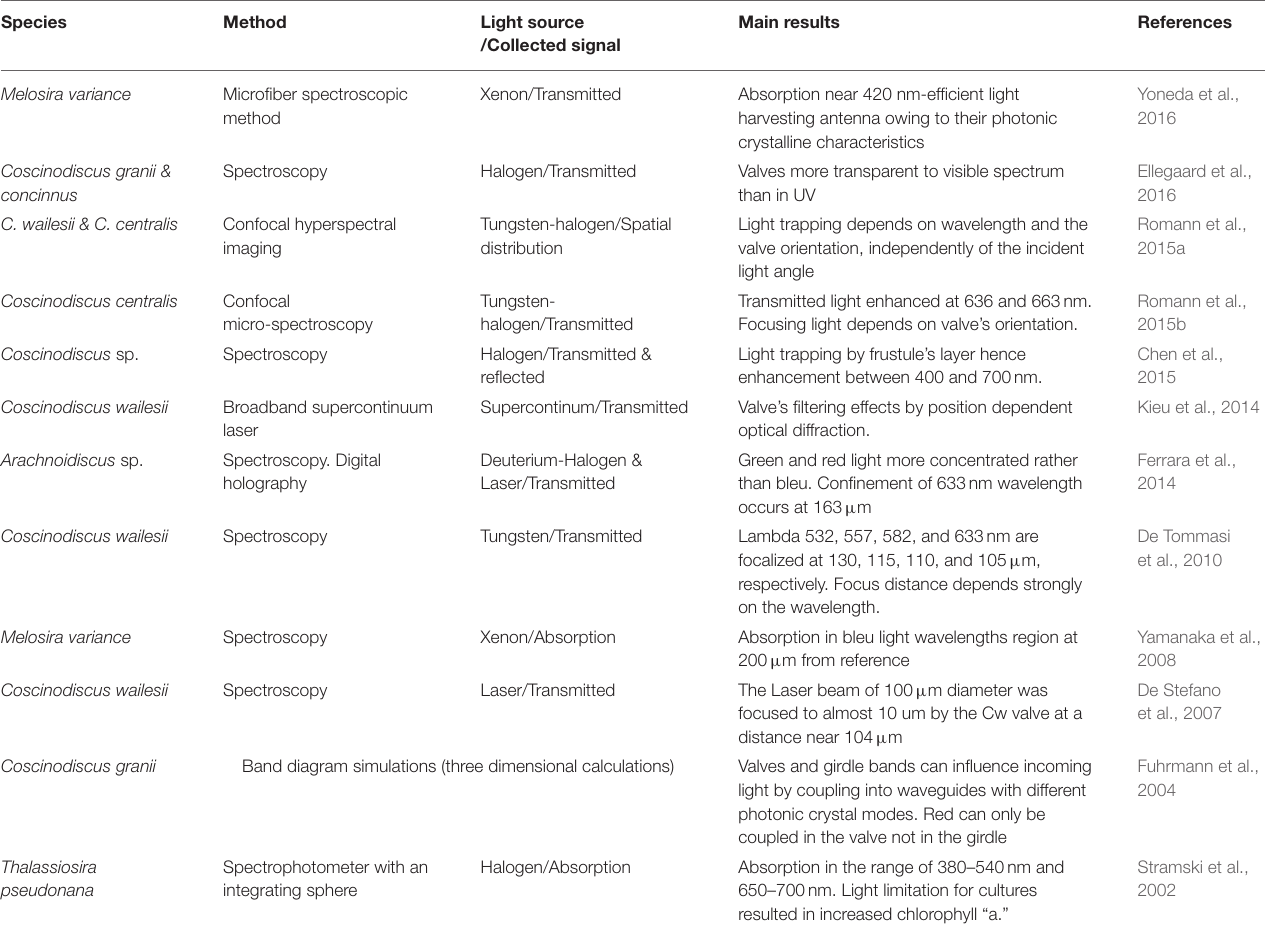
TABLE 1 | Summary of studies on the optical properties of diatoms